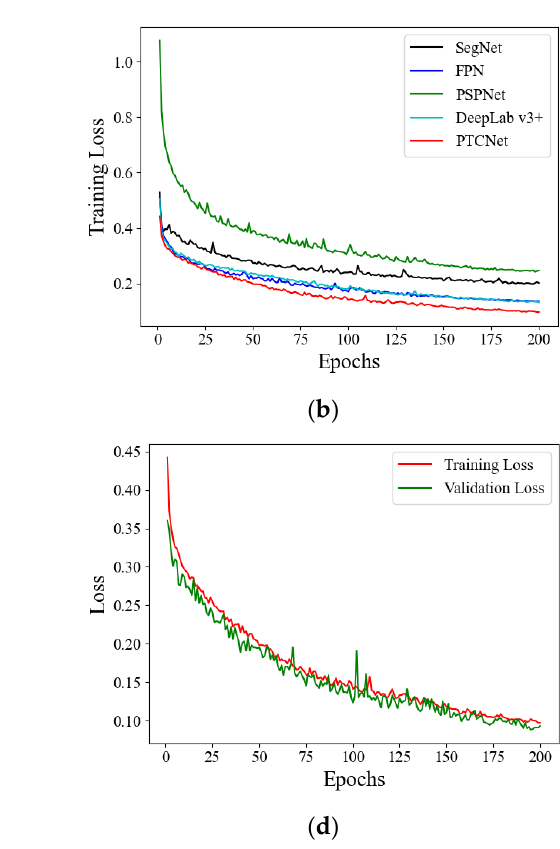
Figure 12. Training effect comparison of PTCNet and other models during training process: ( a ) wheat lodging IoU; ( b ) loss value; ( c ) overall accuracy; ( d ) training loss and validation loss of PTCNet.